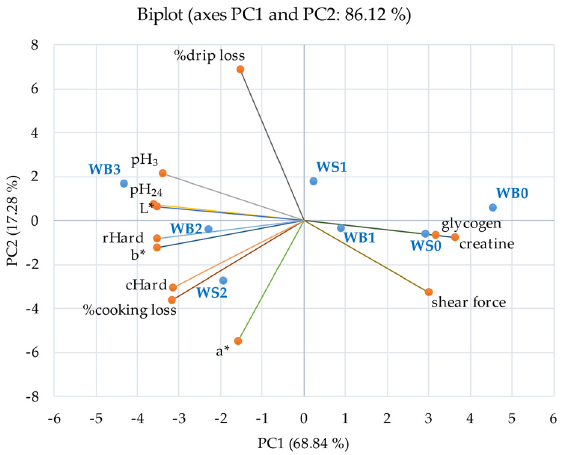
Figure 5. Principal component analysis biplot of the wooden breast (WB) and white stripping (WS) severity score and meat quality attributes of broiler chickens at 42 days of age. WB, 0, 1, 2, 3 = wooden breast scores are based on a 4-point scale (3 = severe, 2 = moderate, 1 = mild, and 0 = normal); WS, 0, 1, 2, 3 = white striping scores are based on a 4-point scale (3 = severe, 2 = moderate, 1 = mild, and 0 = normal). cHard = cooked meat hardness, rHard = raw meat hardness, L* = lightness, a* = redness, and b* = yellowness.